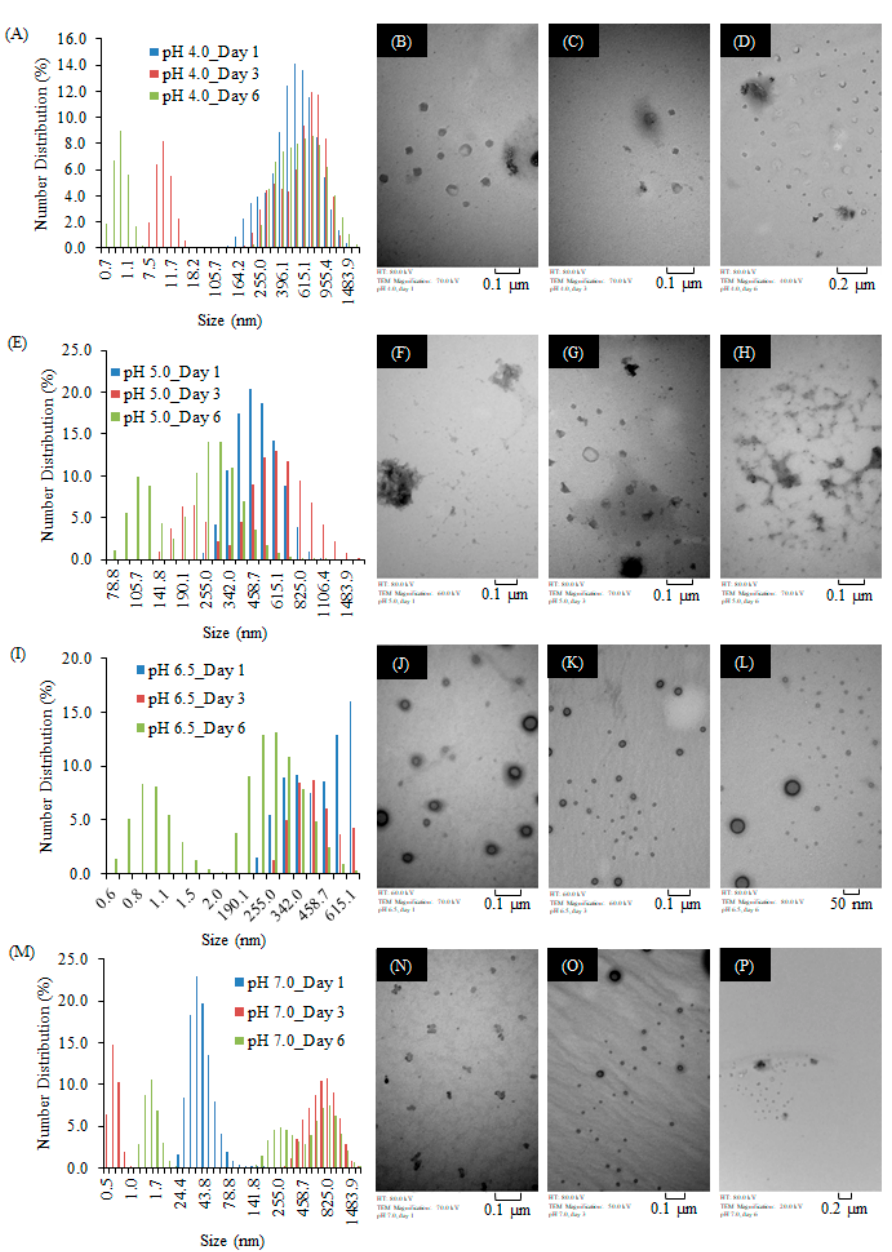
Figure 7. ( A ) DLS of 32 µg/mL GQDs-hMSNs particle degradation at pH 4.0 for 6 days. TEM images of particles at pH 4.0 after ( B ) day 1, ( C ) day 3, and ( D ) day 6. ( E ) DLS of 32 µg/mL GQDs-hMSNs particle degradation at pH 5.0 for 6 days. TEM images of particles at pH 5.0 after ( F ) day 1, ( G ) day 3, and ( H ) day 6. ( I ) DLS of 32 µg/mL GQDs-hMSNs particle degradation at pH 6.5 for 6 days. TEM images of particles at pH 6.5 after ( J ) day 1, ( K ) day 3, and ( L ) day 6. ( M ) DLS of 32 µg/mL GQDs-hMSNs particle degration at pH 7.0 for 6 days. TEM images of particles at pH 7.0 after ( N ) day 1, ( O ) day 3, and ( P ) day 6.